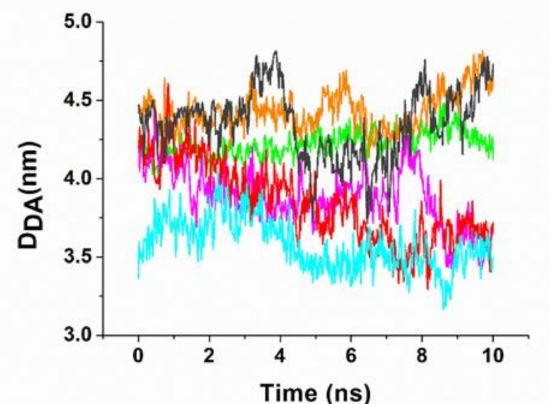
Figure 5. Temporal evolution of the D DA distance between the 5 (cid:48) end of miR4749 and the aromatic ring center of the lateral chain of Trp214 for the six models of the complex during a MD run. Colours are the same as in Figure